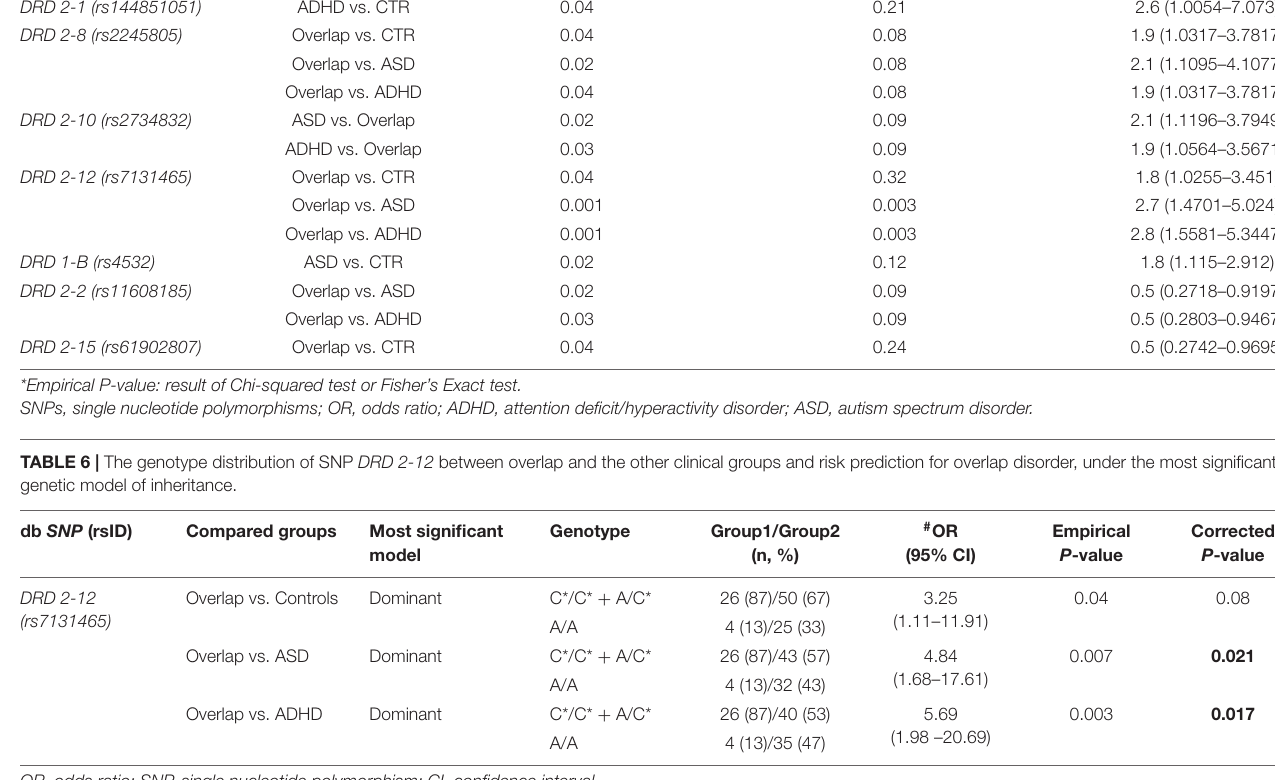
TABLE 5 | Results of the comparative analysis of allelic distribution of the SNPs among the study groups with the corresponding OR values. Polymorphism (rsID) Compared groups Empirical P -value* Corrected P -value for false discovery rate OR (95% CI) DRD 2-1 (rs144851051) ADHD vs. CTR 0 . 04 DRD 2-8 (rs2245805) Overlap vs. CTR Overlap vs. ASD Overlap vs. ADHD